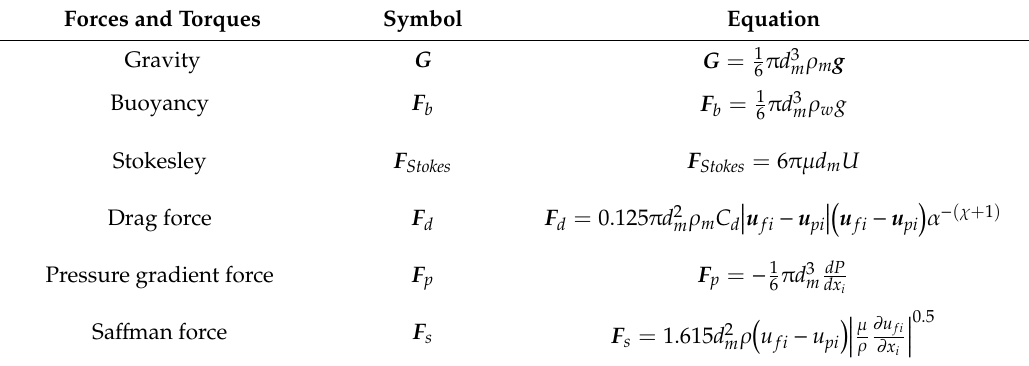
Table 3. Forces and Torques on a